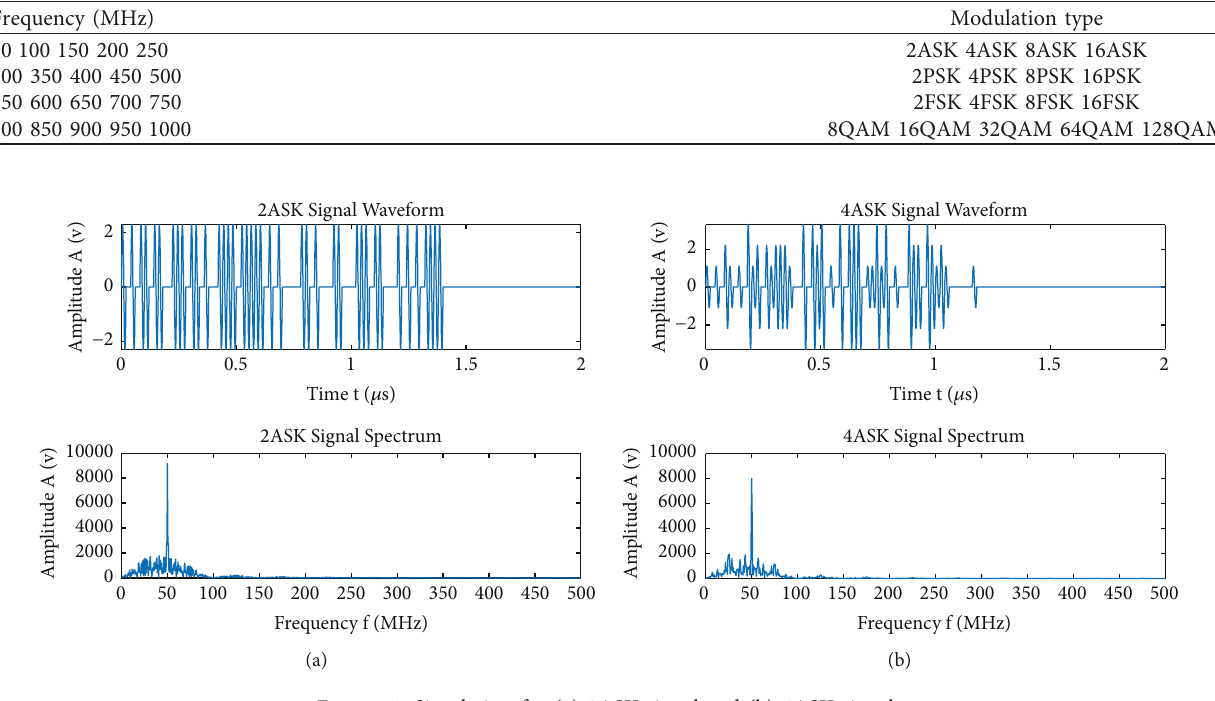
Table 1: Simulation parameters for commutation signal.